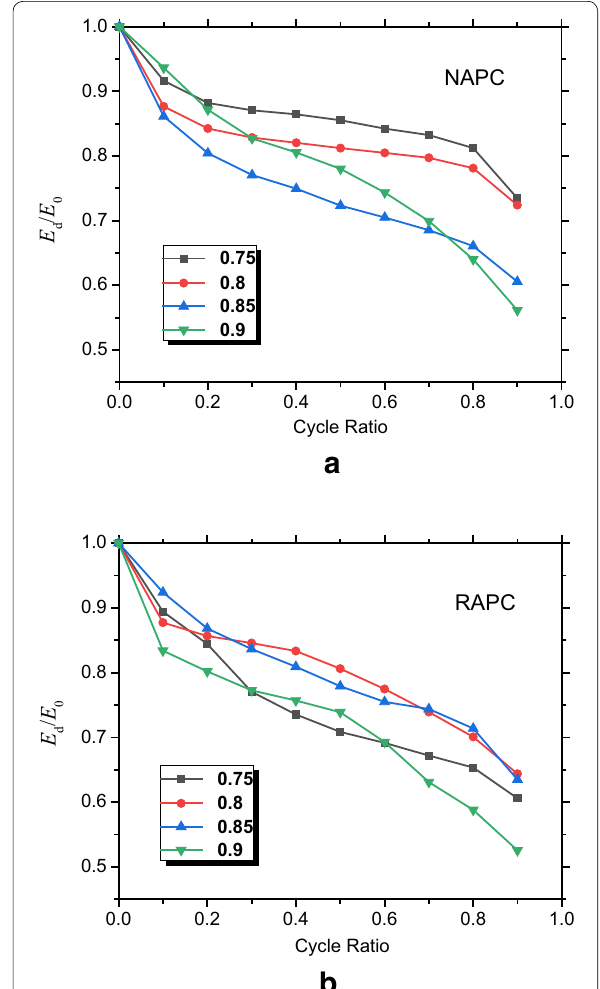
Fig. 7 The variation of E d / E 0 at different cycle ratios under four stress levels: a NAPC and b